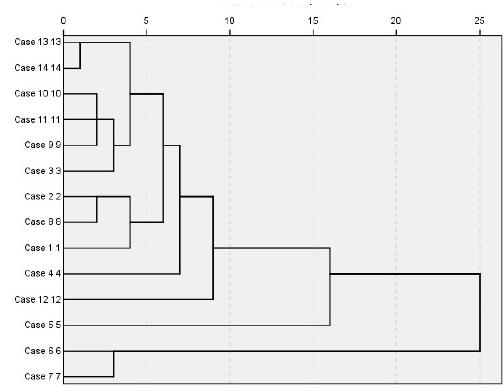
Figure 4. HCA results for 14 sampling sites.